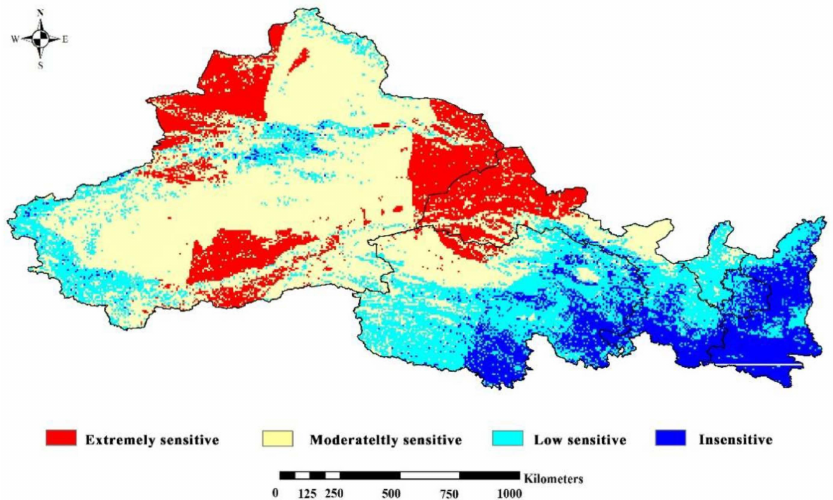
Figure 9. Sensitivity to wind erosion estimated for the case study area, using wind erosion factors estimated for